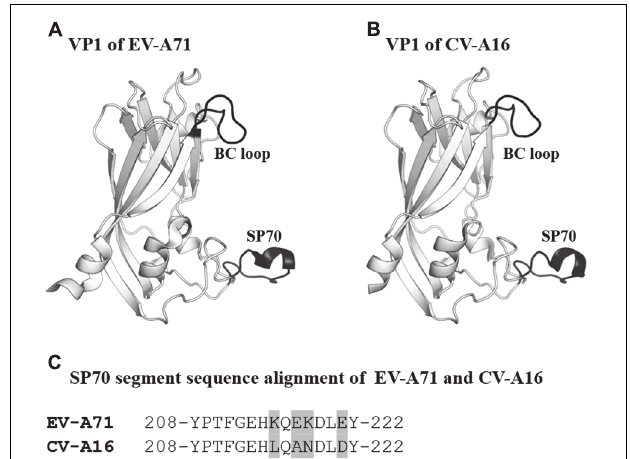
FIGURE 4 | VP1 of EV-A71 and CV-A16. (A,B) Cartoon representation of VP1 (amino acids 76–276) of EV-A71 (PDB ID: 3VBS) and CV-A16 (PDB ID: 5C4W). The BC loop and SP70 region are shown in black and labeled. (C) Sequence alignment of SP70 segments of EV-A71 and CV-A16. Amino acids that are not conserved between the two viruses are highlighted in light